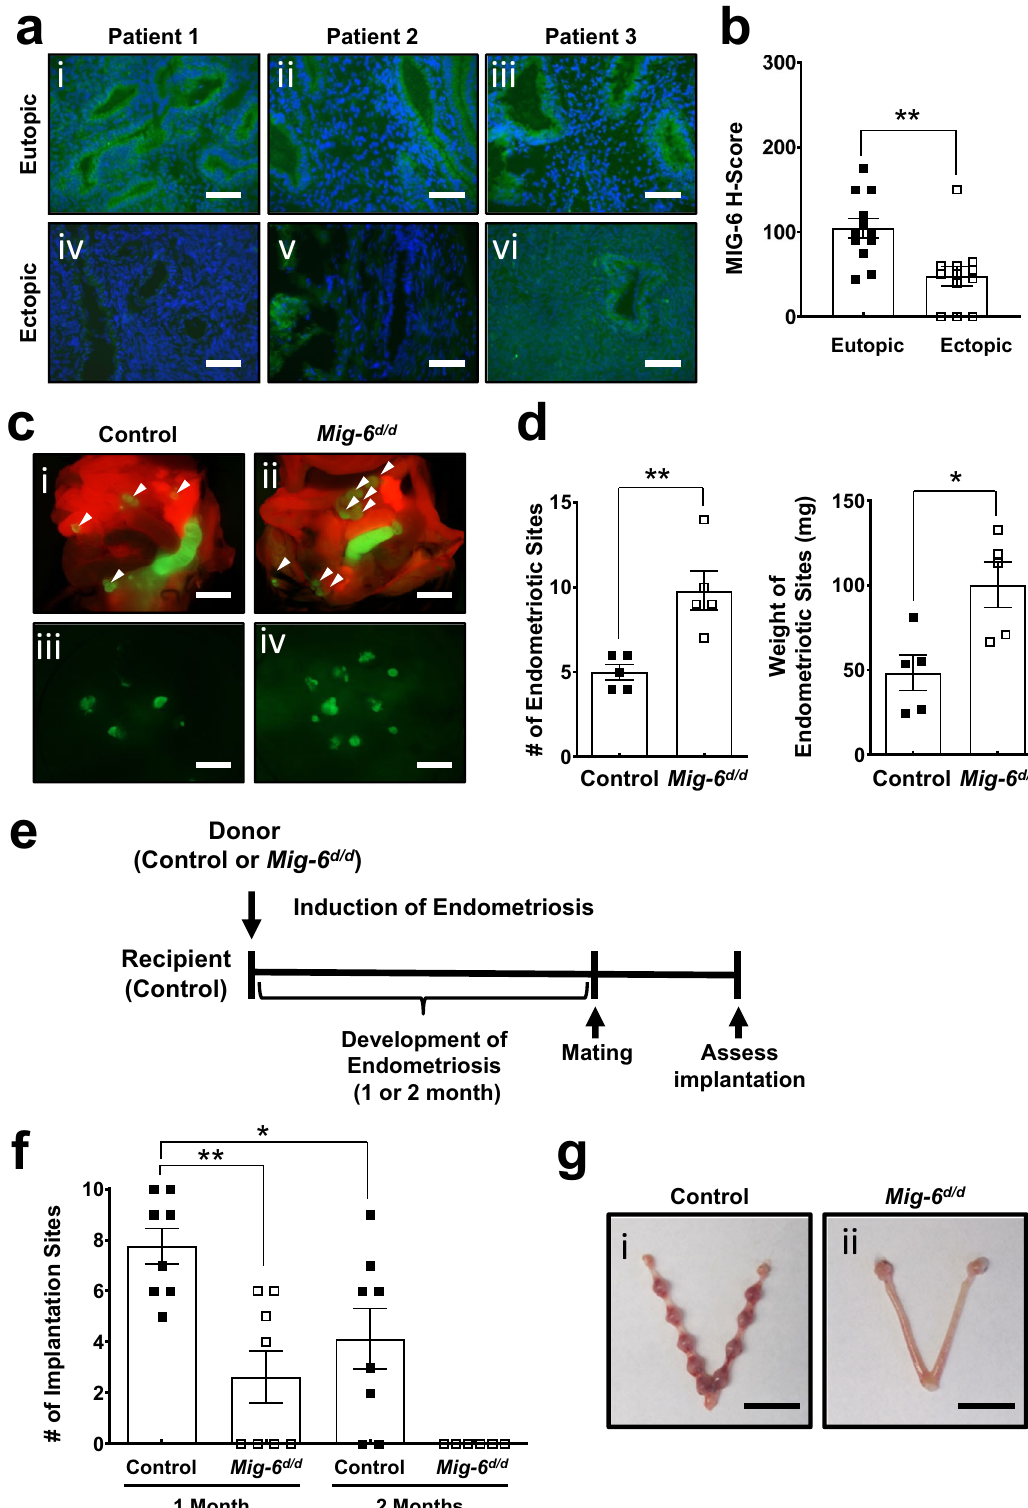
(Fig. 5a – c). IHC results showed that a decrease of PGR expression ESR1 expression was not changed (Supplementary Fig. 6). We then examined whether ERBB2 null mutation can rescue PGR- null mice ’ s endometrial phenotypes. We have generated Pgr cre/cre Erbb2 f/f and Pgr cre/ + Erbb2 f/f mice to determine the